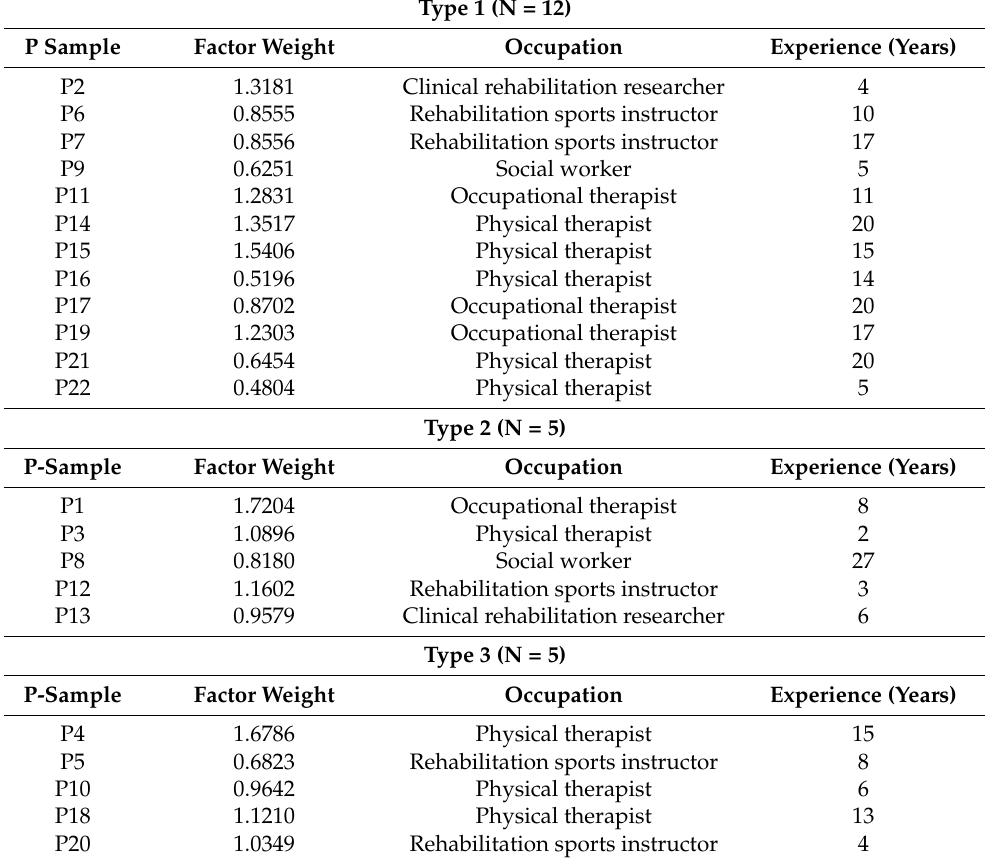
Table 5. Participants and factor weight by